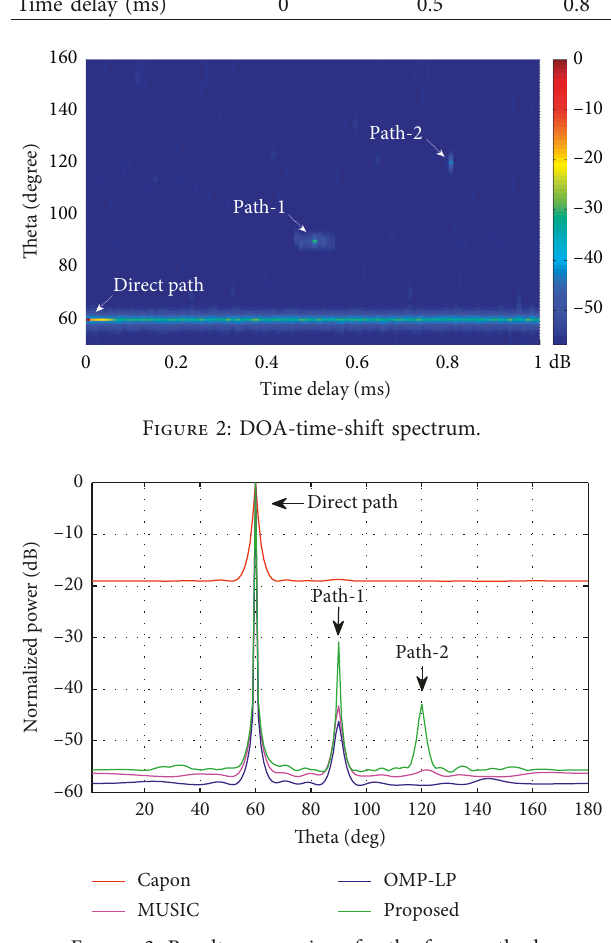
Figure 3: Results comparison for the four